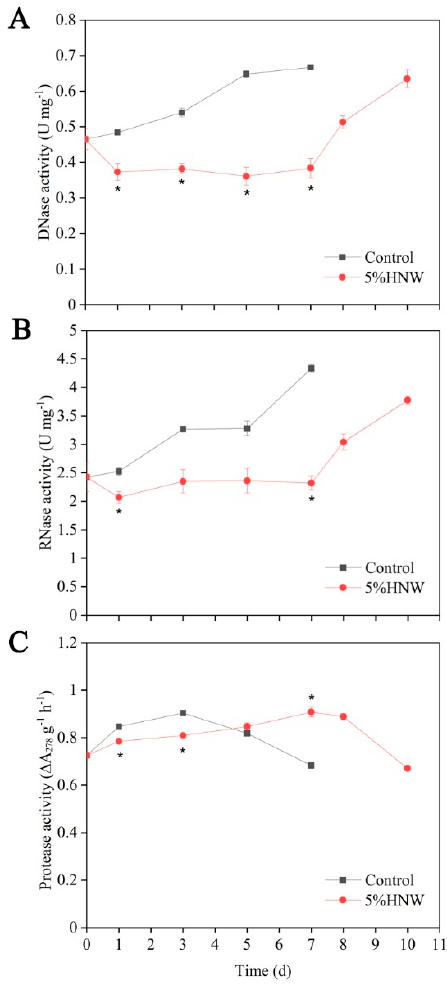
Figure 4. Effects of hydrogen nanobubble water (HNW) on the activities of DNase ( A ), RNase ( B ), and protease ( C ) in petals. Cut flowers were incubated in distilled water (control) and 5% HNW for 3 d (changed daily), and then, in distilled water, which was replaced daily until the end of experiments. Values were expressed as the means ± SE. Three samples per replicate were selected, and total samples in triplicate were 9 (3 × 3) for each treatment at each time point. Asterisks indicated significant differences at p < 0.05 according to t